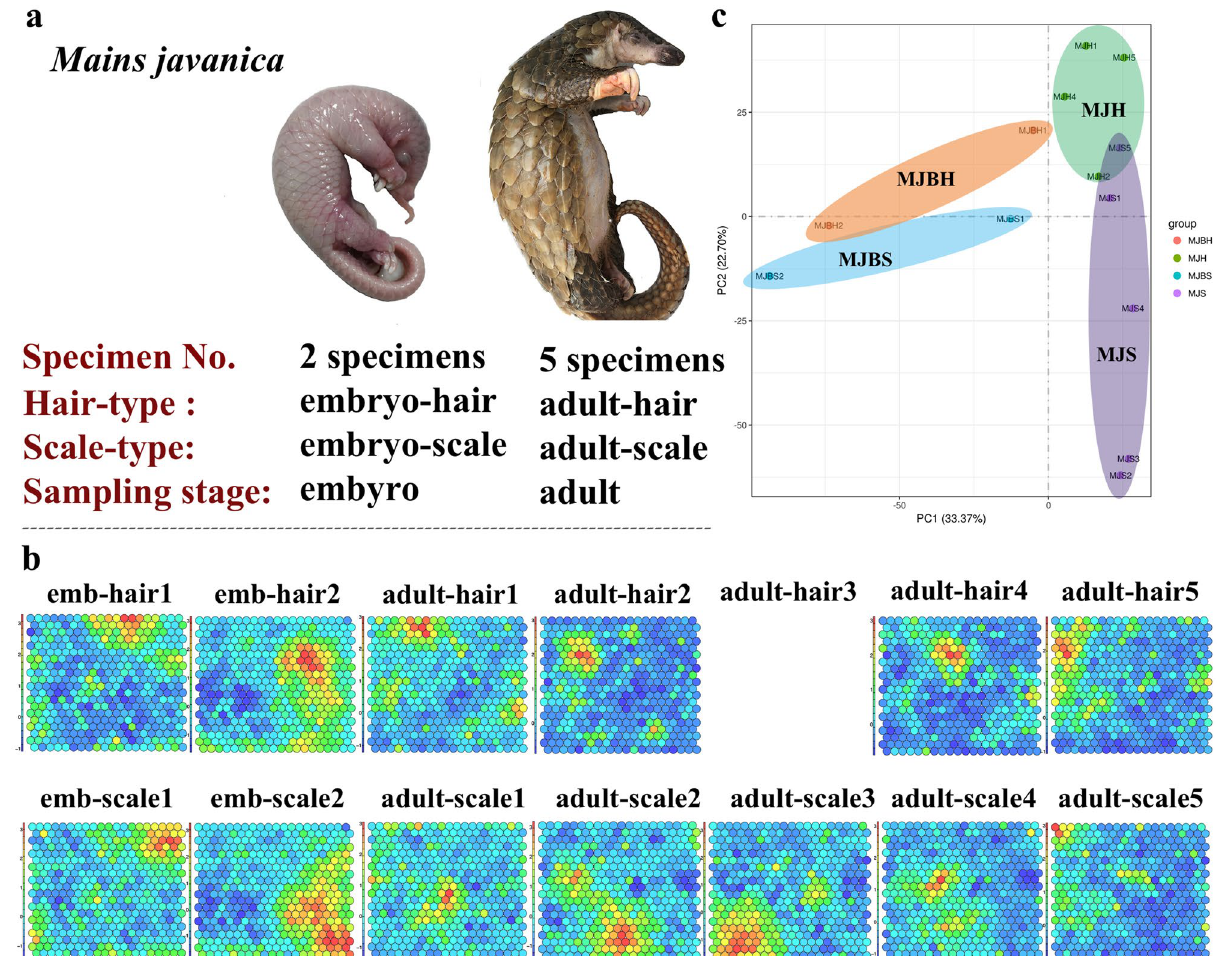
Figure 1. Sample information, SOM module, and PCA analysis. ( a ) Different phenotypes from two different development stages of Manis javanica .; ( b ) Gene expression-specific and phenotype-specific gene-trait correlation analysis based on self-organizing feature map module analysis (SOM module), colour scale of SOM component plane represented the mean ratio in each map node, and red indicates high expression, blue indicates low expression; ( c ) Principal components analysis (PCA) displaying biological variation between scale- type and hair-type samples in pangolin skin appendages. (The adult-hair3 sample in the sequencing results was of poor quality so this sample was deleted).